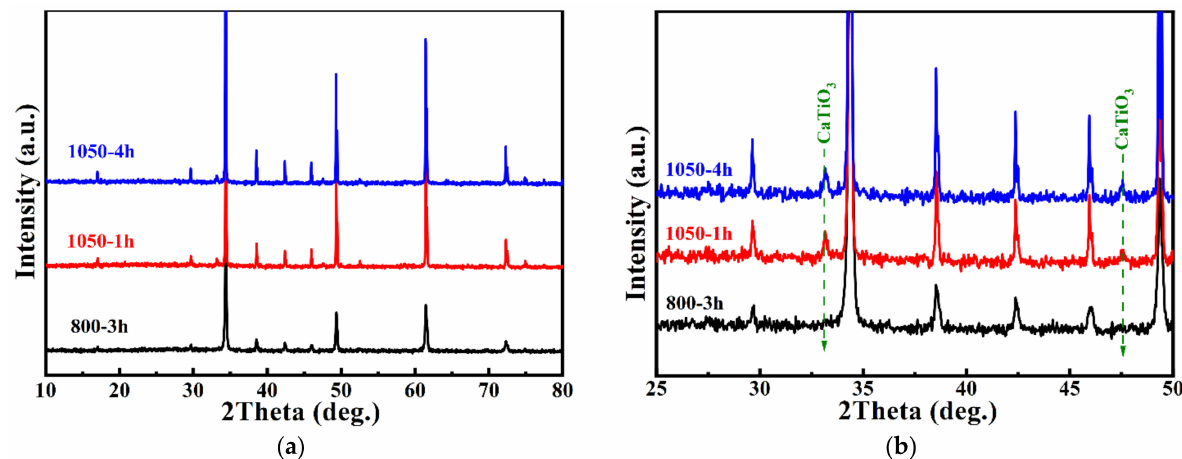
Figure 5. ( a ) XRD patterns of CCTO-800-3 h, CCTO-1050-1 h, and CCTO-1050-4 h; and ( b ) the enlarged spectra of ( a ).